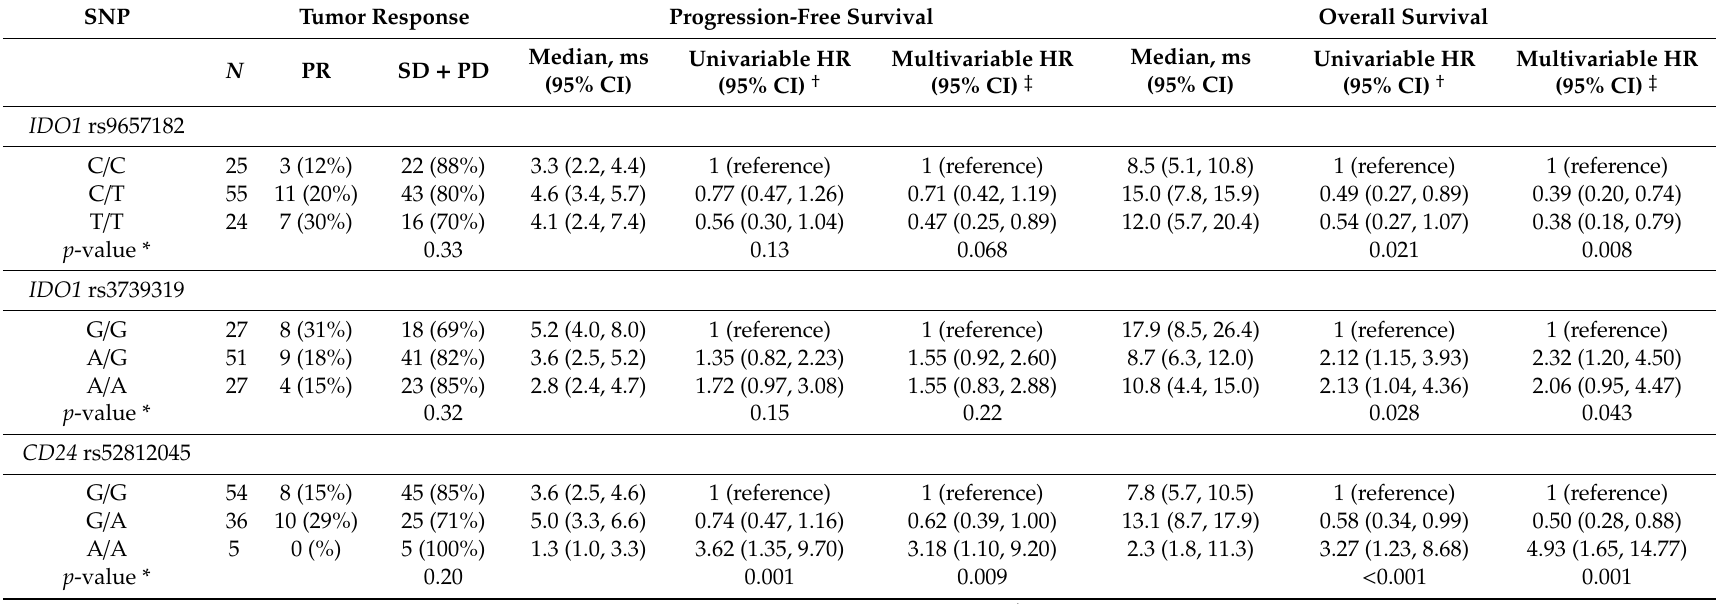
Table 2. Immune regulatory single nucleotide polymorphisms (SNPs) and outcomes in patients with advanced colorectal cancer (CRC) treated with cetuximab-based therapy (training cohort, Italian +